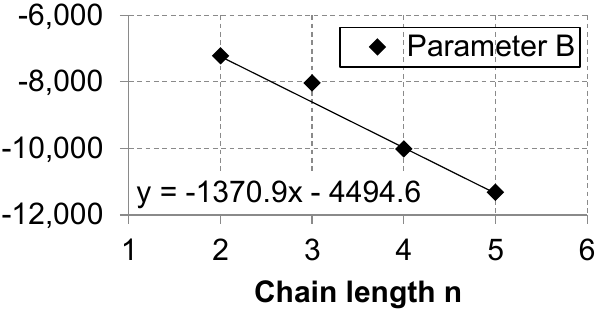
y = -1370.9x - 4494.6